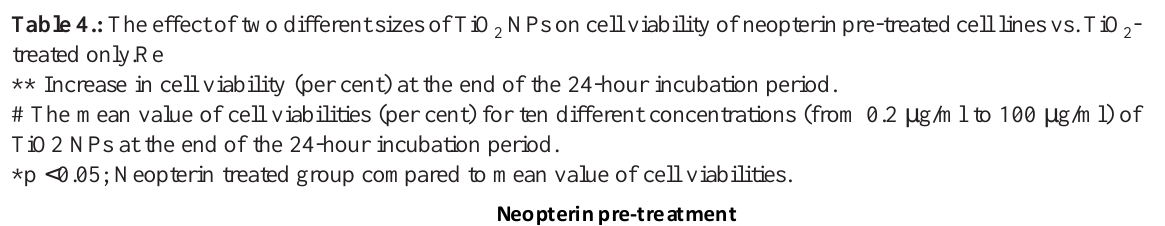
NPs on cell viability of neopterin pre-treated cell lines vs. TiO 2